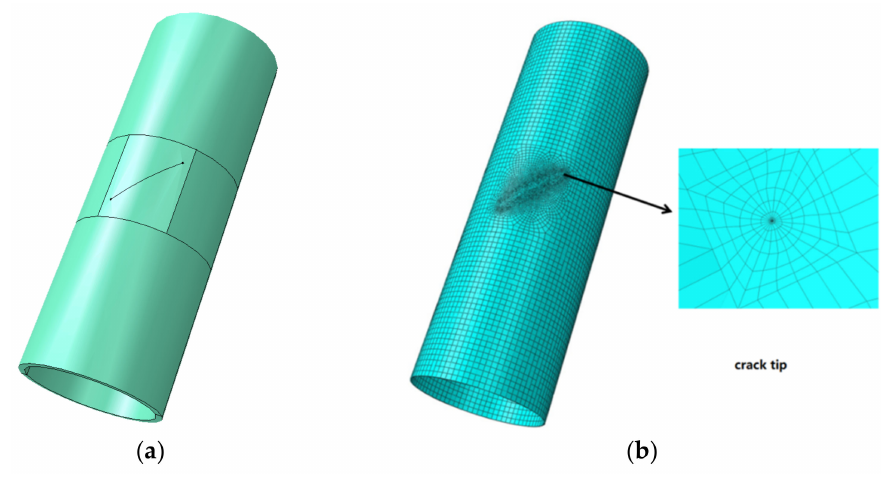
Figure 3. ( a ) Finite element model with clamped on both ends; ( b ) Finite element